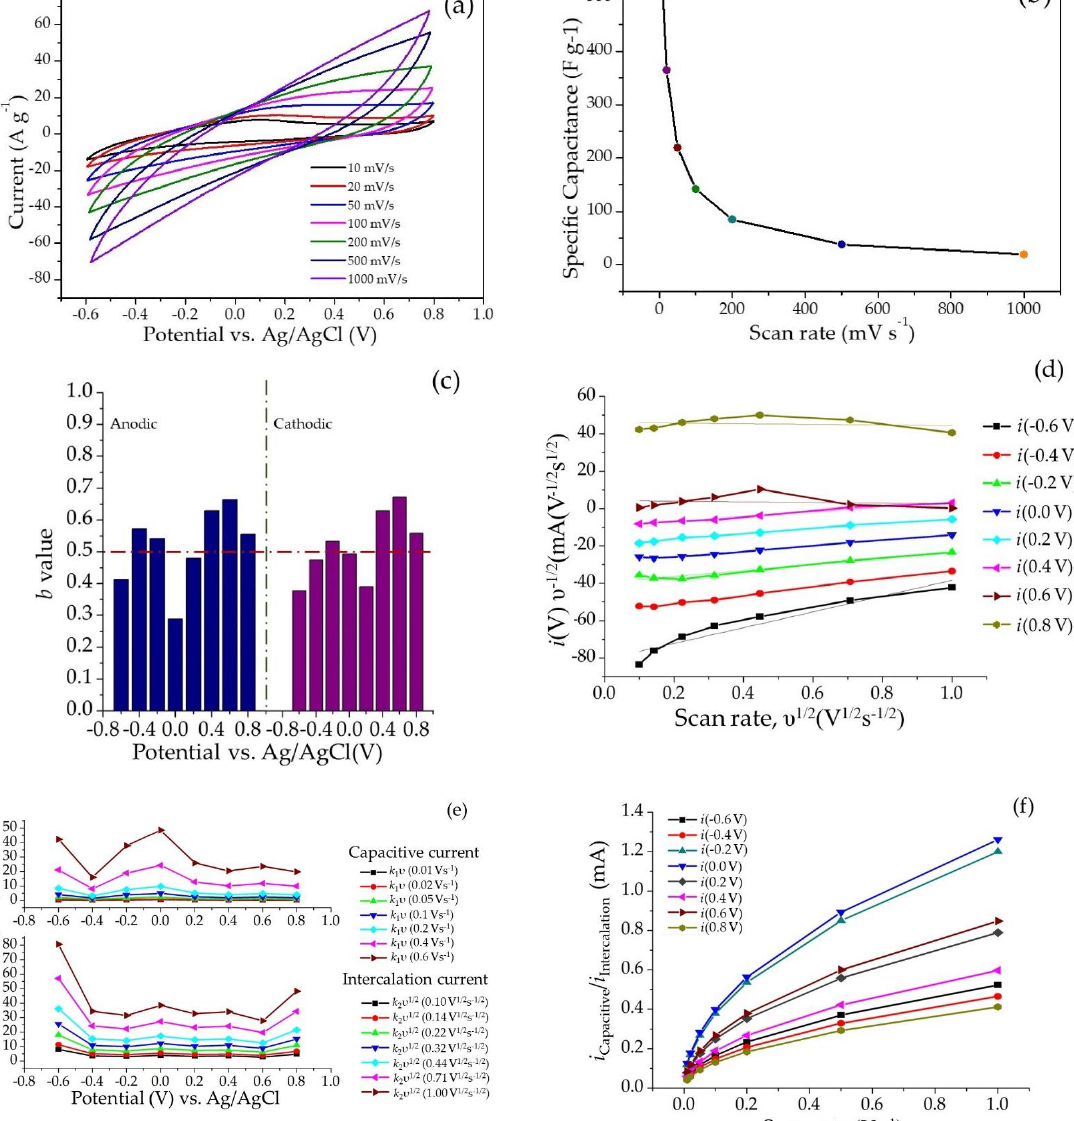
where ‘ i ’ is the voltametric current (A), ‘ m ’ is the mass of the electroactive material, ‘ v ’ is the voltage scan rate, and ‘( V f − V i )’ is the applied voltage ( V ). The specific capacitance calculated for the material is 507 F g − 1 at the scan rate of 10 mV s − 1 , which still